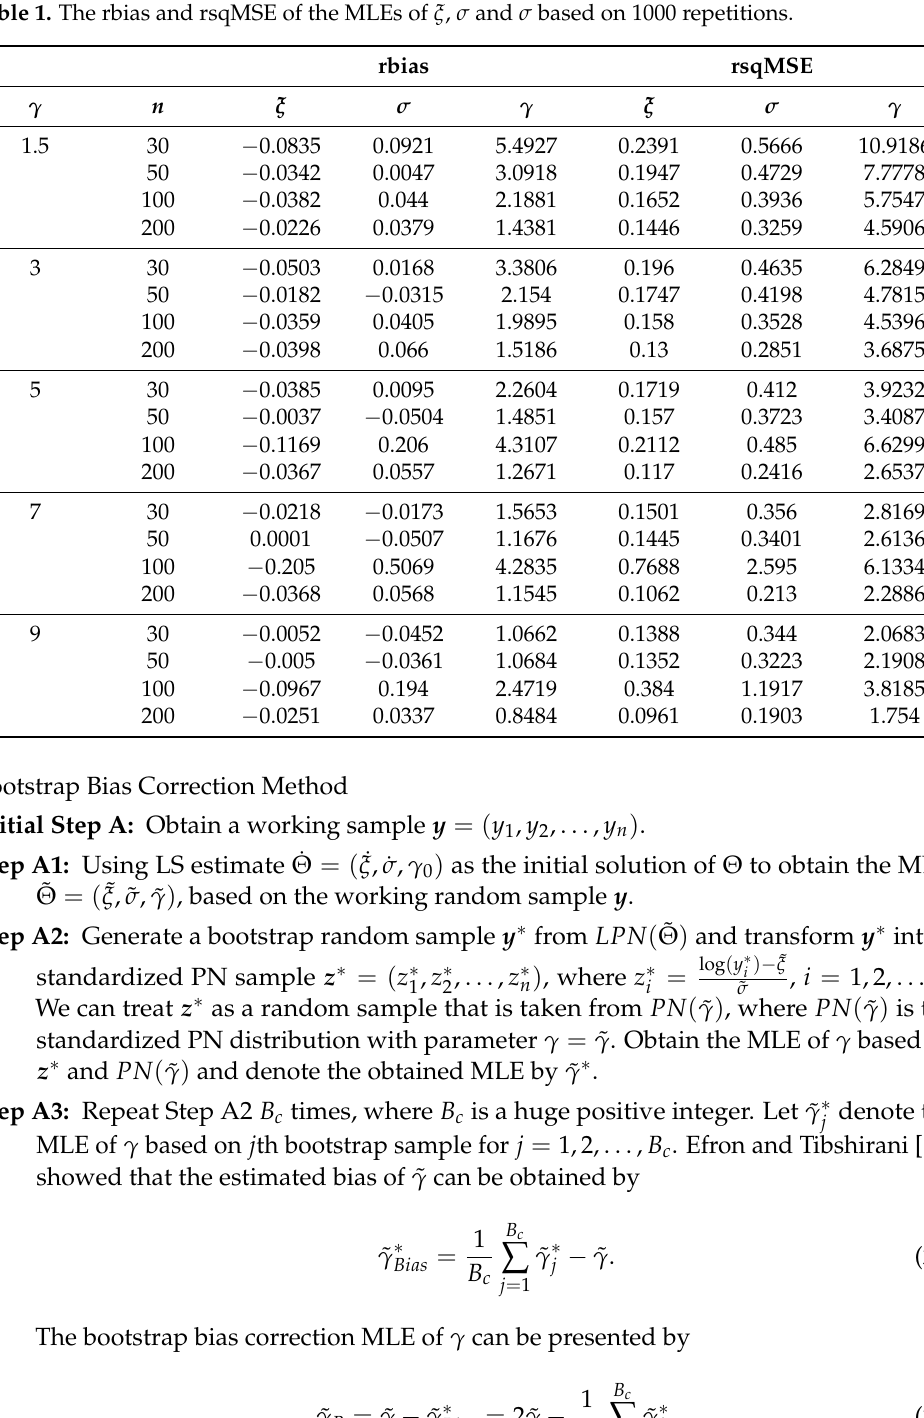
Table 1. The rbias and rsqMSE of the MLEs of ξ , σ and σ based on 1000